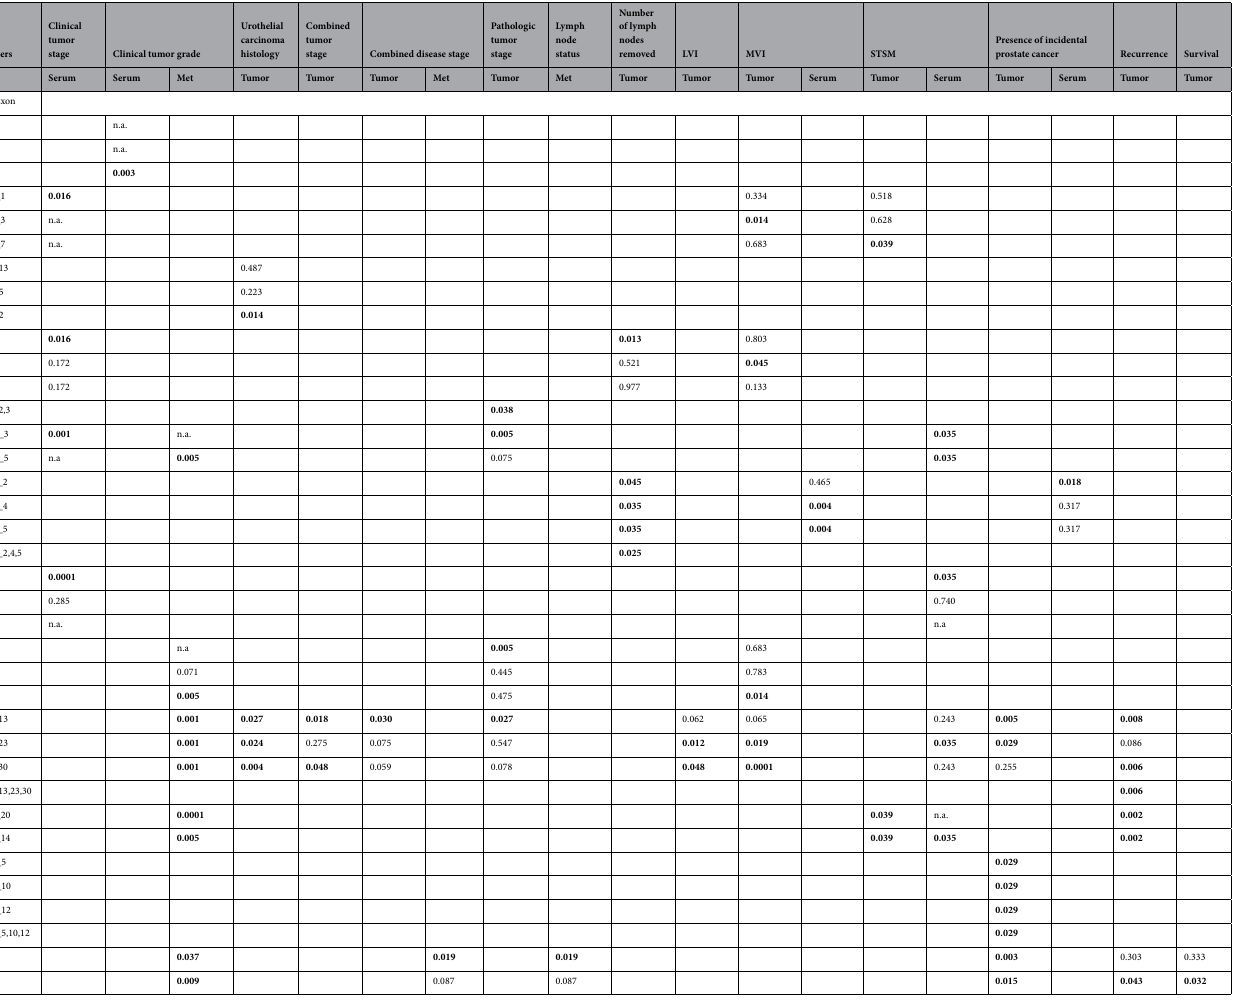
Table 3. Associations of CNV with clinico-pathologic UCB characteristics in 43 UCB patients treated with RC. Only those genes with CNV are shown. The significant p-values are in bold. The insignificant p-values are also shown if one or two exons of the same gene display a significant p-value. EGFR epidermal growth factor receptor, MET mesenchymal-epithelial transition, GATA4 GATA binding protein 4, FGFR1 fibroblast growth factor receptor 1, MYC myelocytomatosis, PTP4A3 protein tyrosine phosphatase 4A3, CCND1 cyclin D1, KLF5 Kruppel-like Factor 5, ERBB2 Erb-b2 receptor tyrosine kinase 2, TOP2A DNA topoisomerase II alpha, CCNE1 cyclin E1, TURB transurethral resection of bladder, RCE radical cystectomy, ConcCIS concomitant carcinoma in situ, N lymph node, MVI microvessel invasion, STSM soft tissue surgical margin, PCa prostate cancer, n